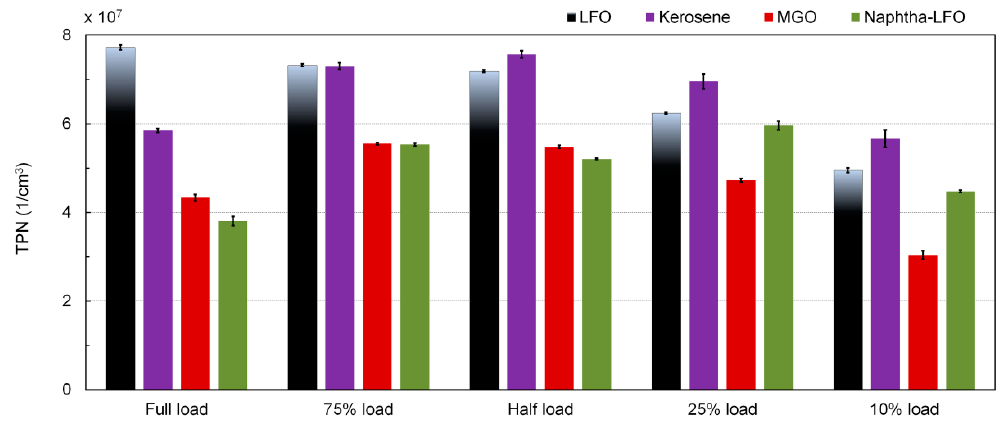
Figure 7. Total particle number (TPN) at different engine loads.